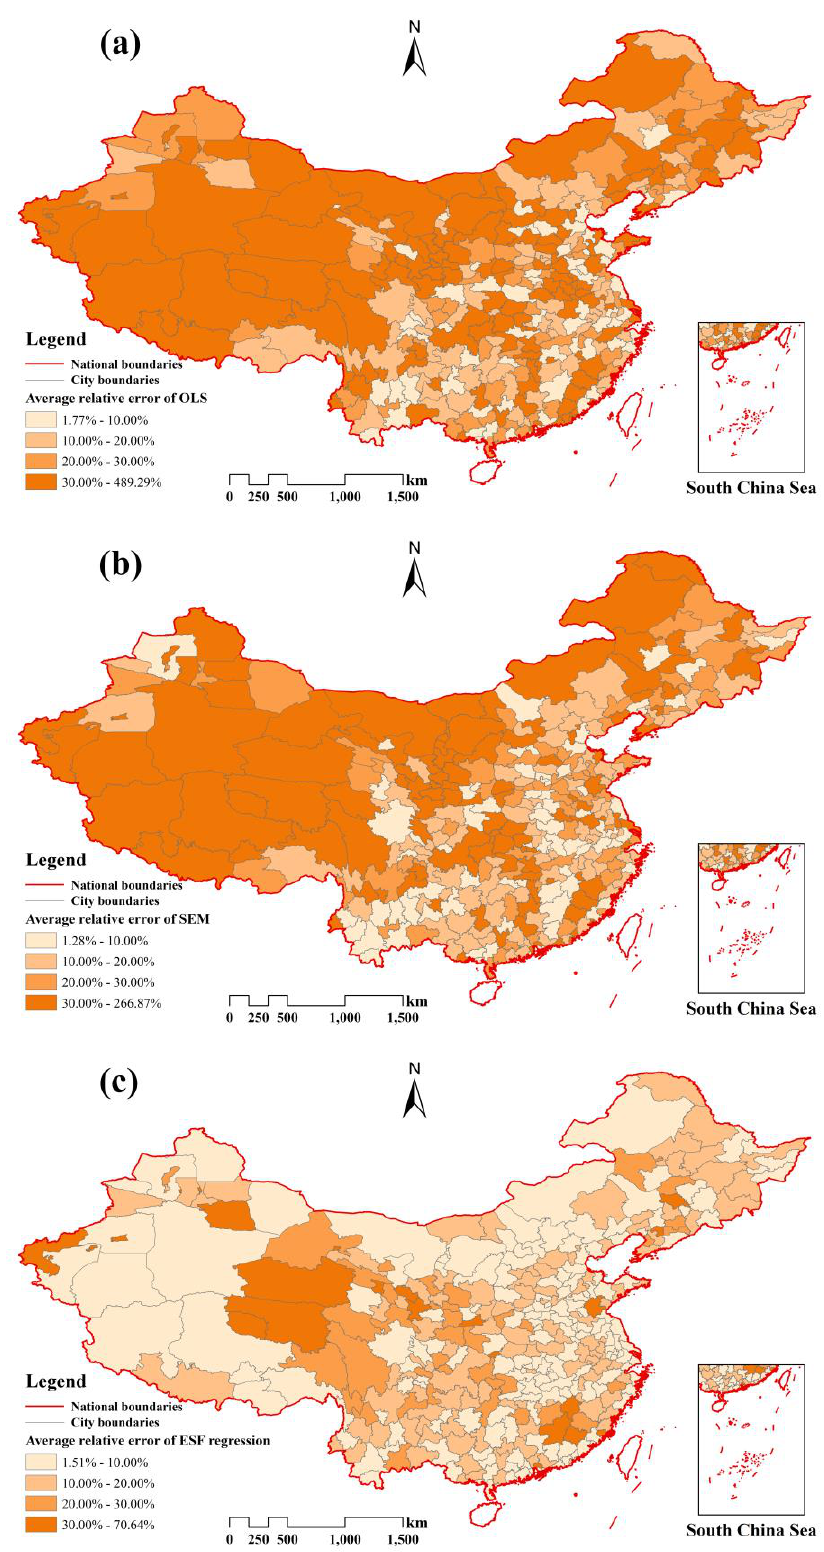
Figure 6. 3-year mean values of the absolute value for the regional relative error: ( a ) The OLS mean relative errors. ( b ) SEM mean relative errors. ( c ) ESF mean relative errors.